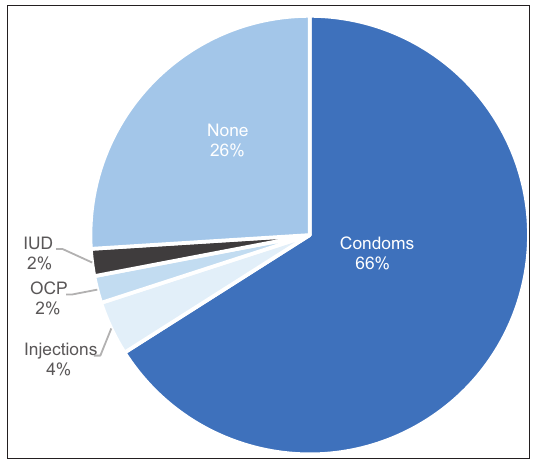
Figure 1: Method of family planning among sexually active women (N=50).